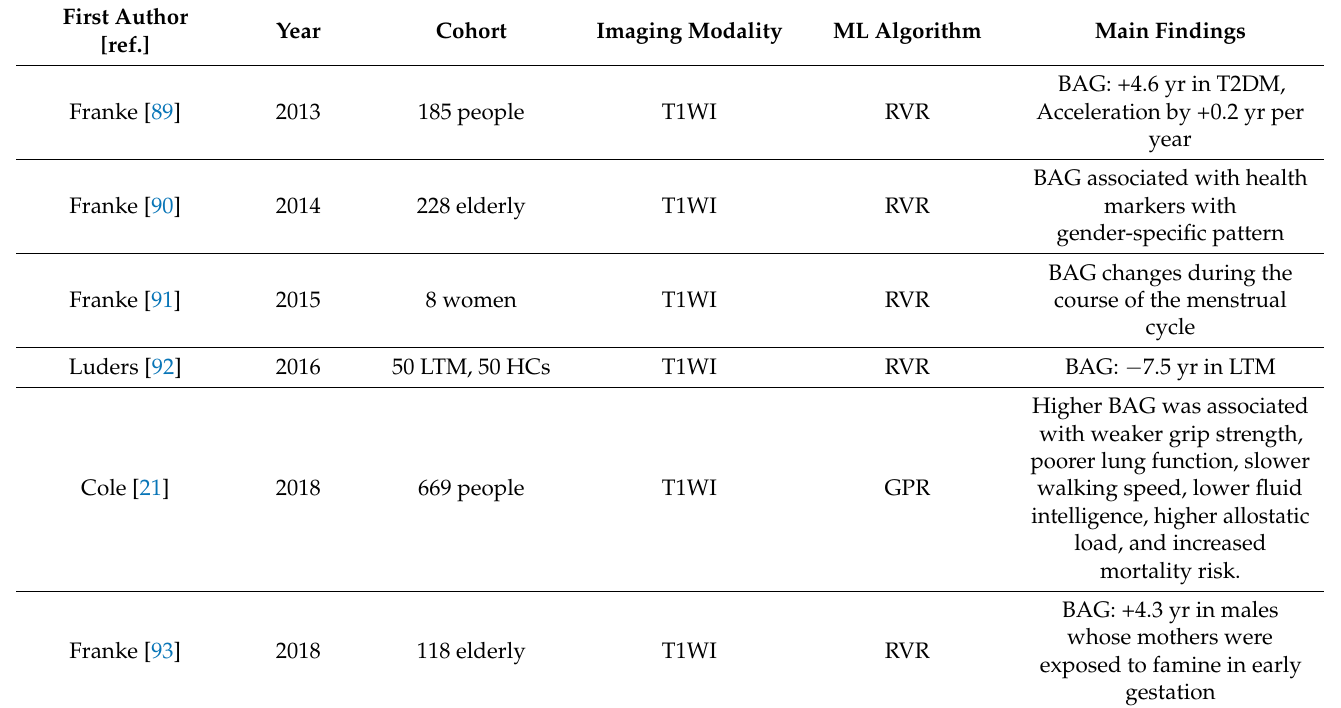
Table 3. Neuroimaging-based brain age studies for general populations or those without neuropsy- chiatric